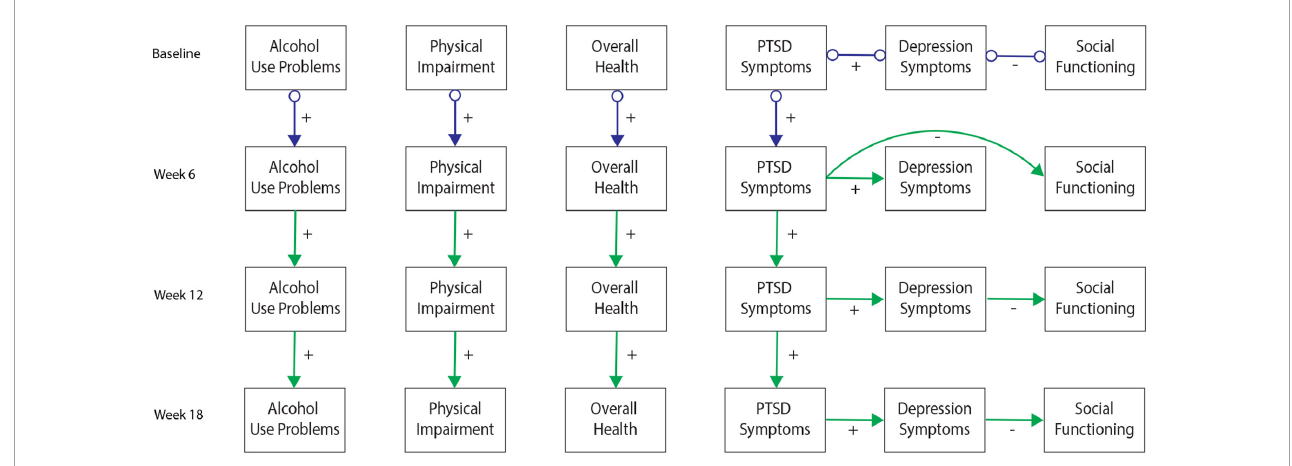
FIGURE3 Greedy Fast Causal Inference (GFCI) graph for the Coordinated Anxiety Learning and Management (CALM) sample ( n = 79). First independent replication of causal links between post-traumatic stress disorder (PTSD) symptoms and depression over the course of 18 weeks in the CALM sample, leading to social functioning, which are all independent of overall health, physical health, and alcohol use problems. Colored arrows indicate the level and directionality of the causal edges, with + or – along the edges indicating whether these links cause increases or decreases in scores on the connected measures.